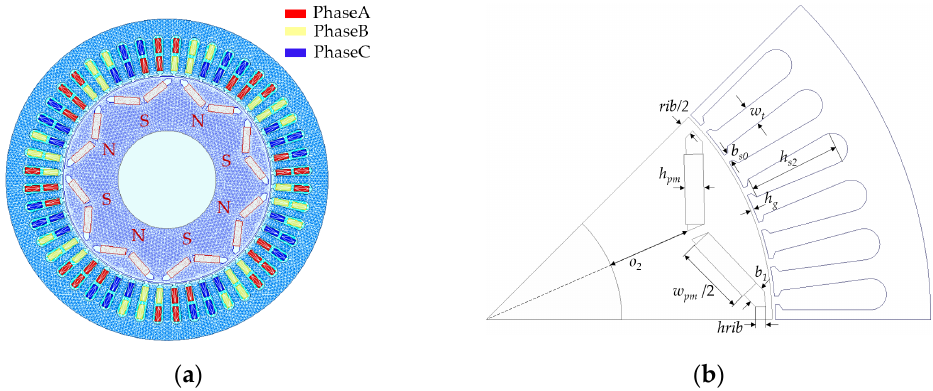
Figure 1. Model of IPMSM: ( a ) grid partitioning; ( b ) 1/8 parameterization model.